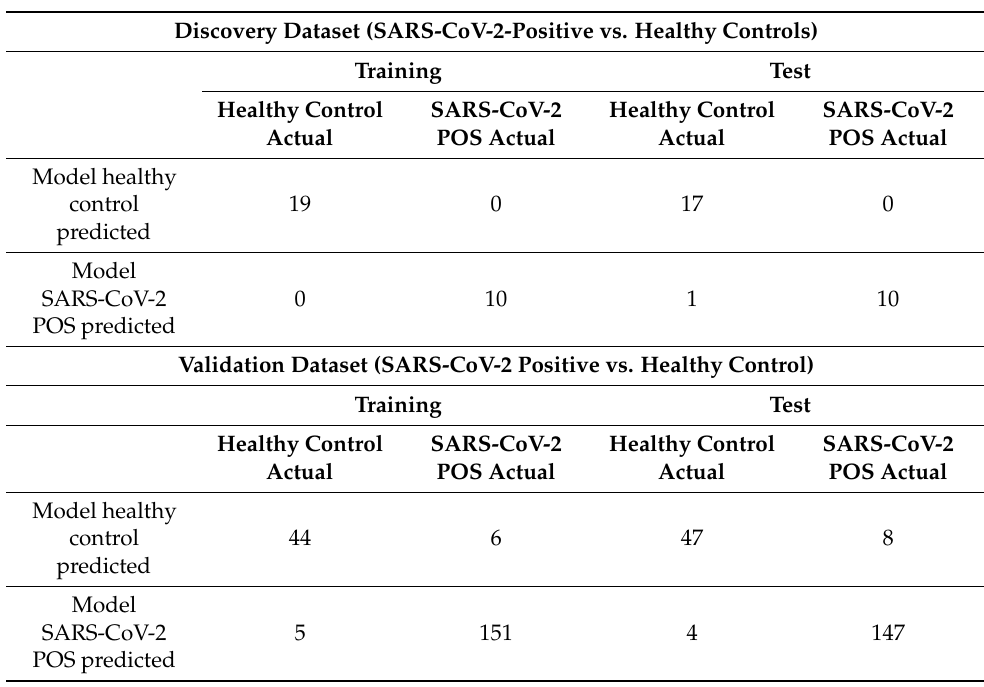
Table 3. Confusion matrices for the logistic regression models in the discovery and validation data presented in Figure